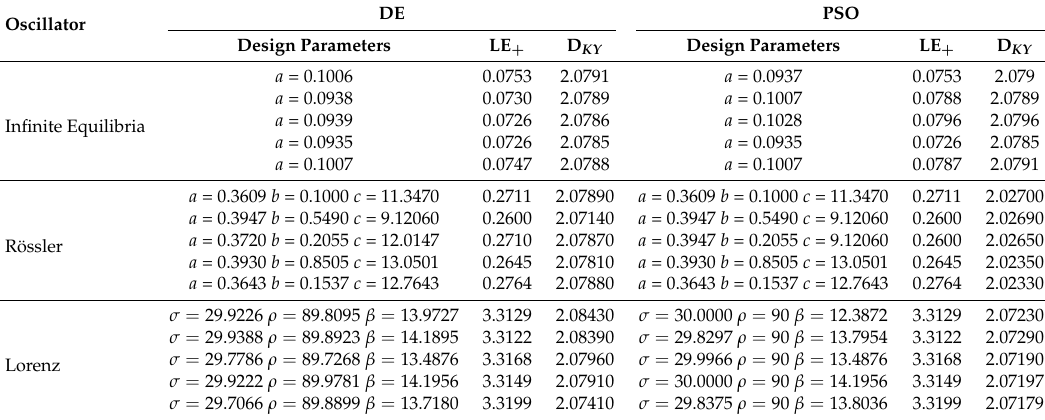
Table 4. Design parameters of the five highest values of D KY from Table 3, for each metaheuristic and chaotic oscillator, and their corresponding value of